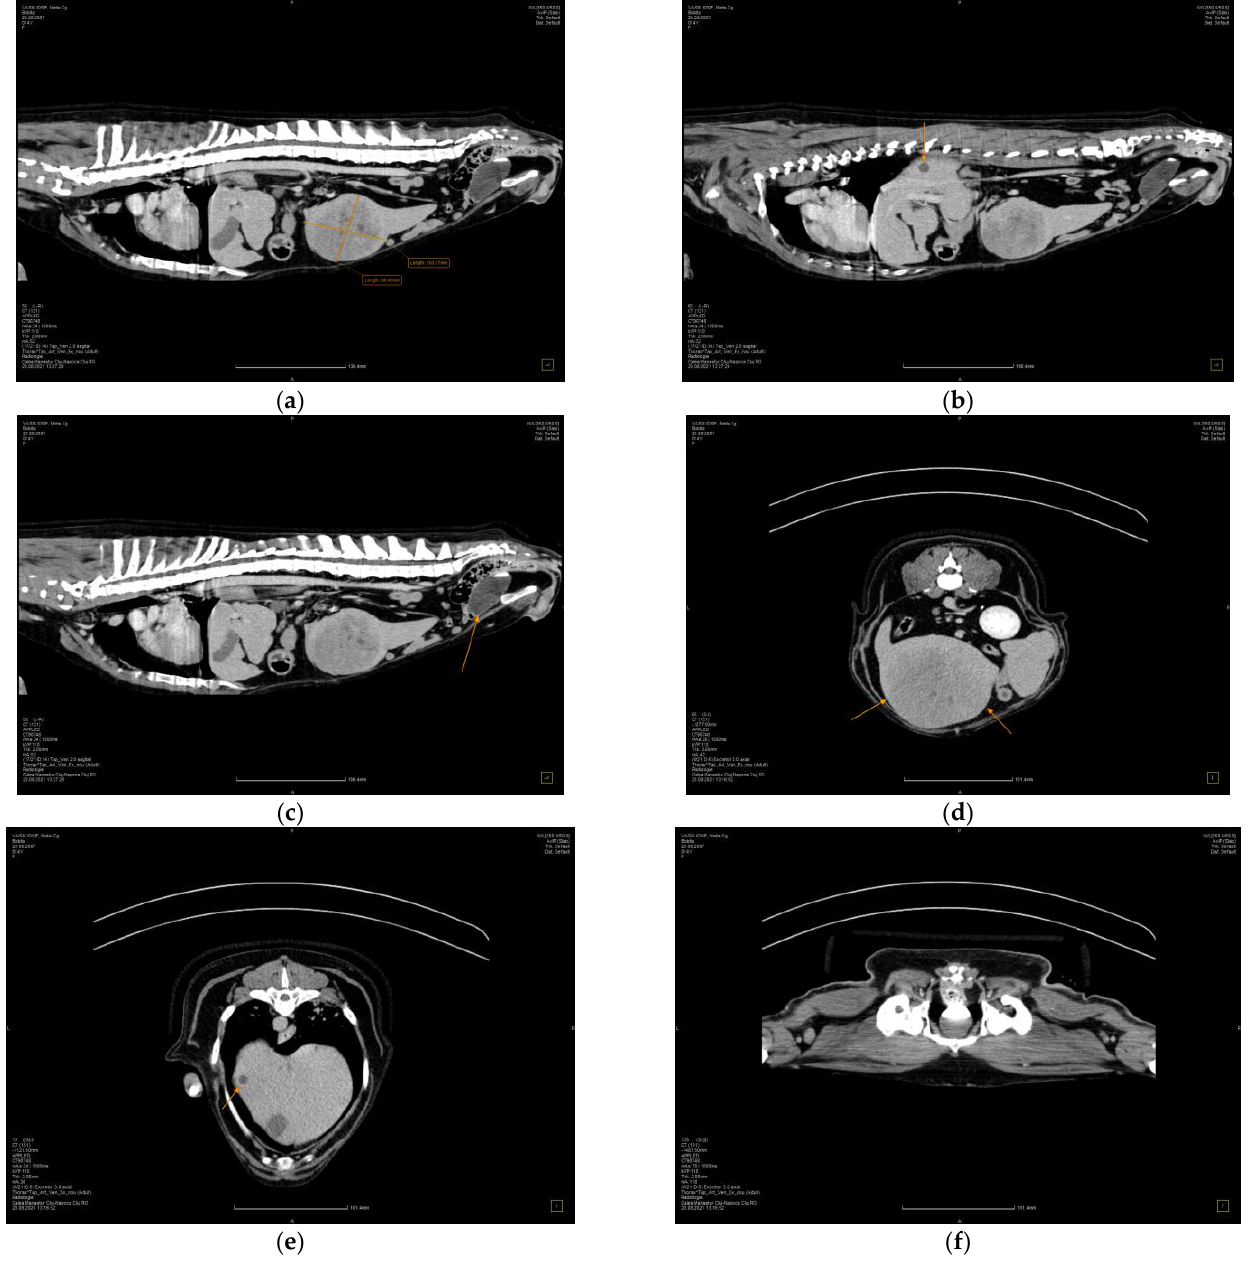
Figure 1. CT evaluation of the abdomen a, b, c: Sagittal view of the thorax and abdomen; d,e,f: axial view of the ab- domen and pelvis. The reconstruction is made at different